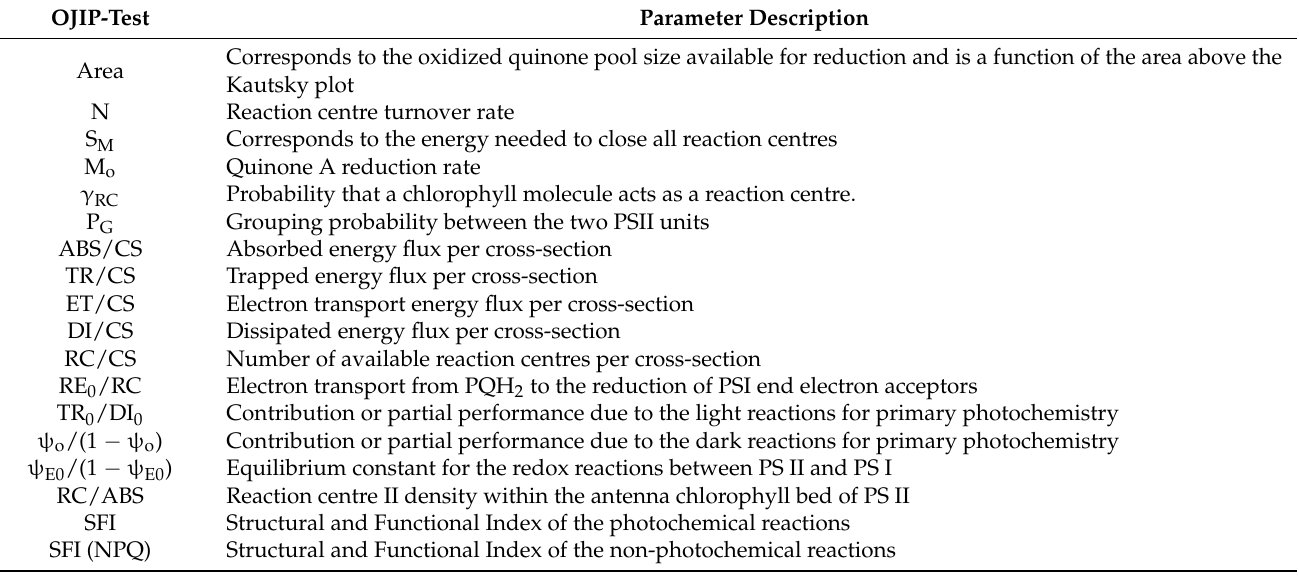
Table 1. Summary of the photochemical parameters used in the present work and their description. Parameter